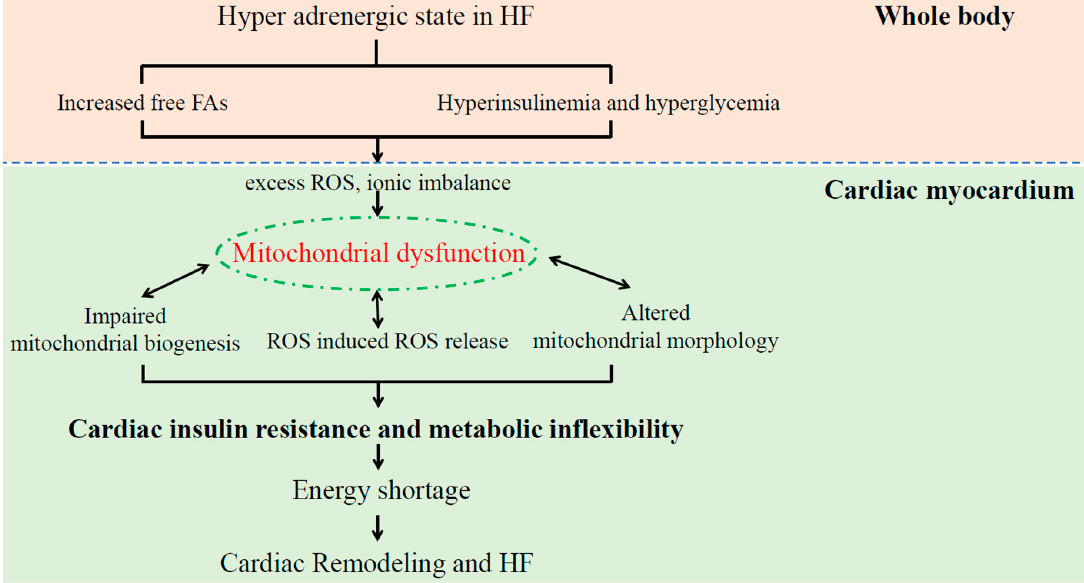
Figure 2. The role of mitochondrial dysfunction in the pathogenesis of cardiac insulin resistance and HF.